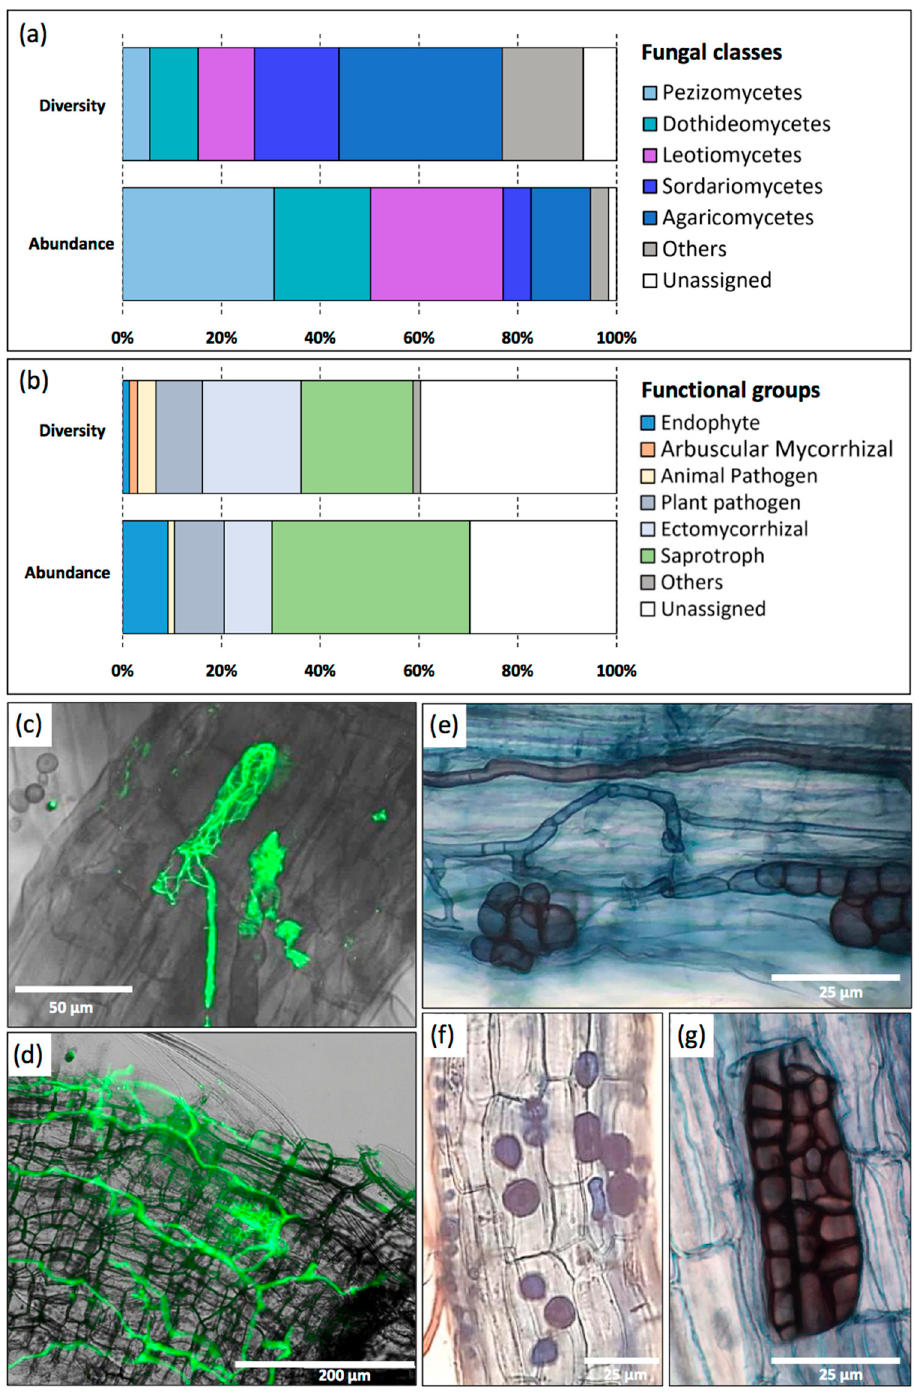
Figure 5. Relative diversity and abundance (%) of the most represented fungal classes ( a ) and func- tional groups of fungi ( b ) associated with the roots of nettle from the Fresnes-sur-Escaut site. The classes with a relative abundance <5% and the less abundant and diverse functional groups have been gathered in the group “others” (Adapted from [123]). Endophytic fungal structures observed by fluorescence ( c , d ) and photonic ( e – g ) microscopy in preparations of nettle roots labelled with WGA-AF488 or stained with trypan blue, respectively. ( c ) fungal hyphae colonizing a cortical cell; ( d ) network of extracellular fungal hyphae; ( e ) hyphae forming brain-like microsclerotia; ( f ) intracel- lular fungal spores with various morphologies; ( g ) melanized fully packed microsclerotia (Yung et al., unpublished data).